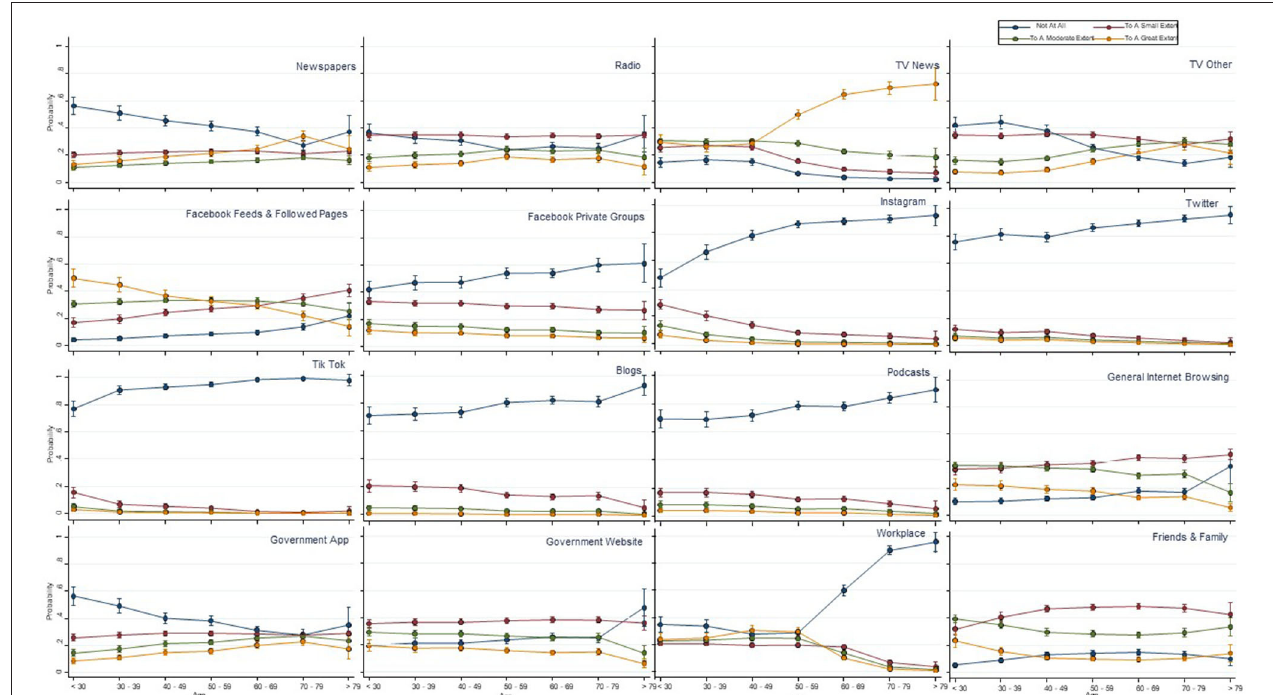
FIGURE 1 | Sources of exposure to COVID-19 information across age groups (probability of each response with 95%CI).